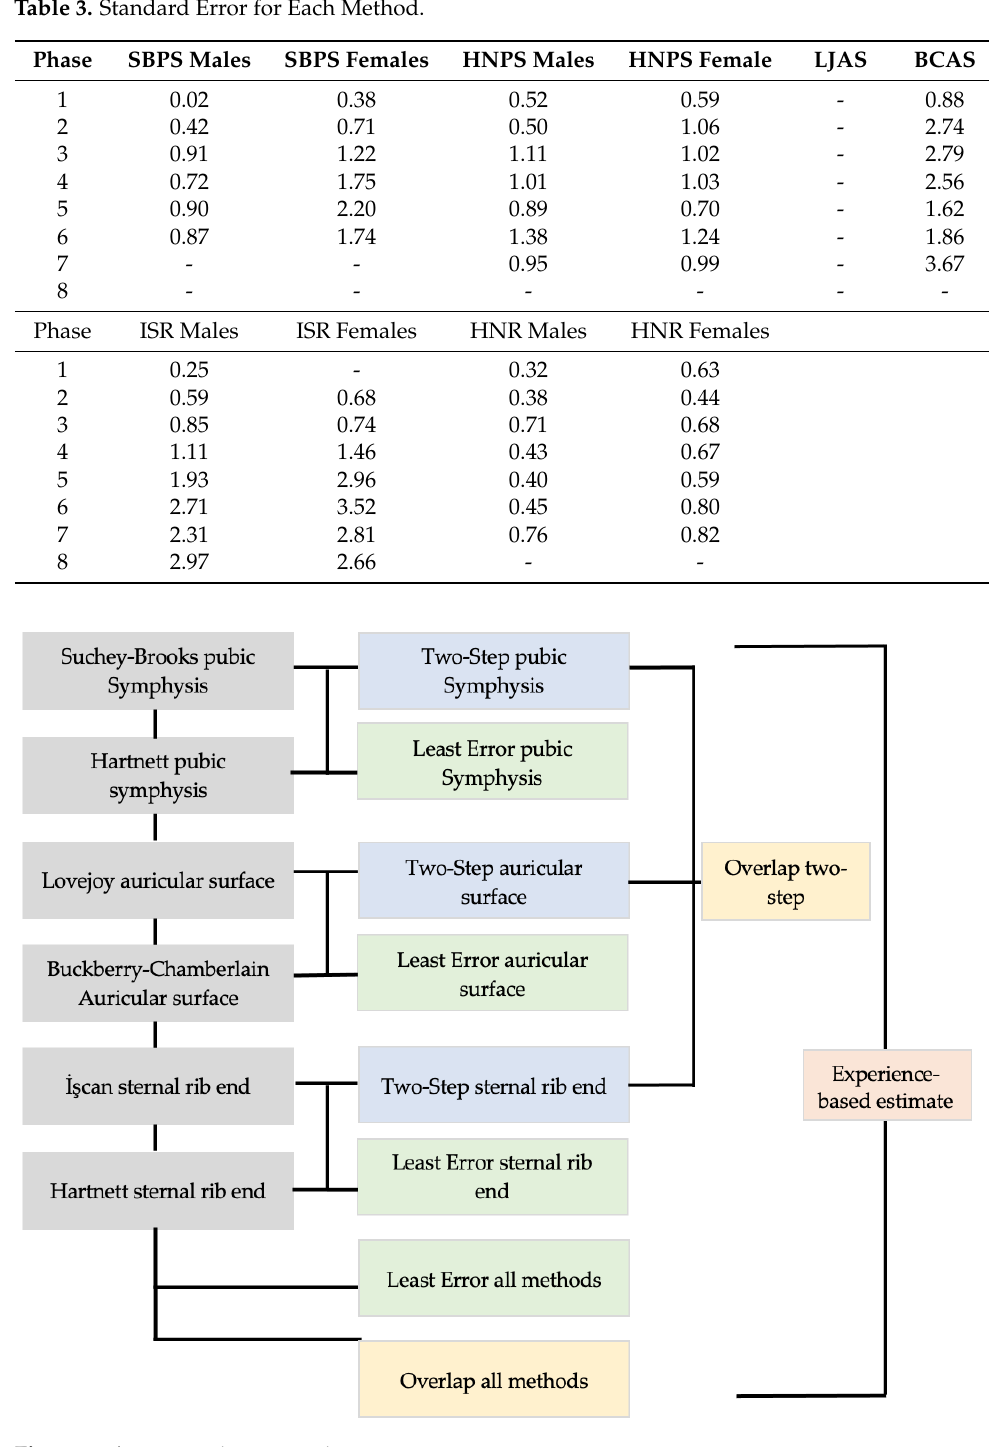
Figure 1. Age-reporting strategies.